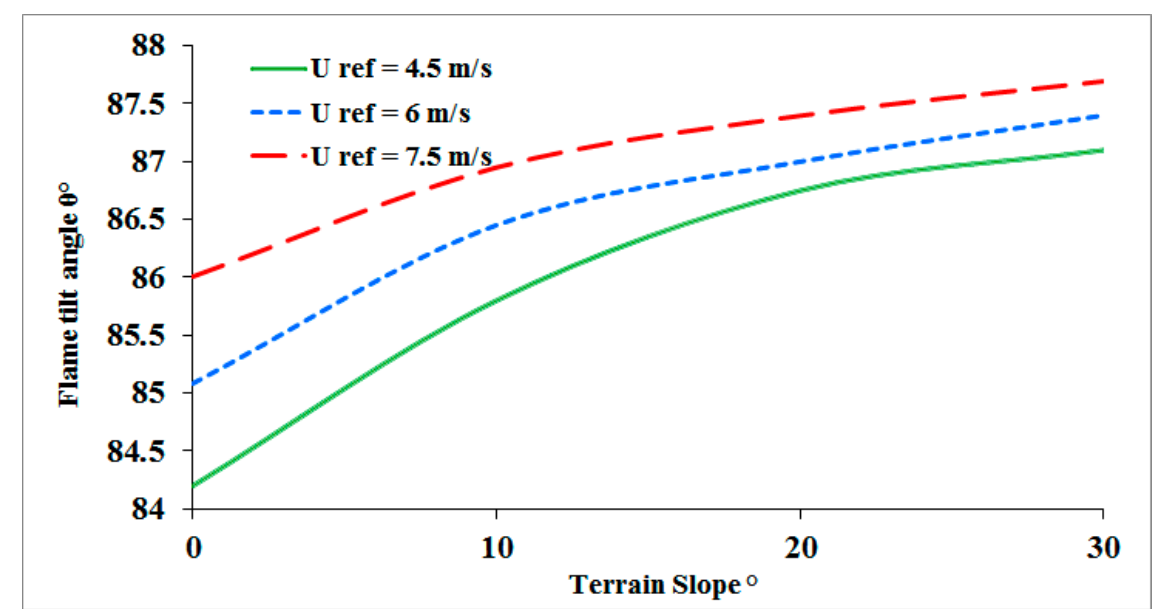
Figure 5. Average tilt angle for U ref = 4.5, 6, and 7.5 m/s and terrain slope 0°, 10°, 20°, and 30°.